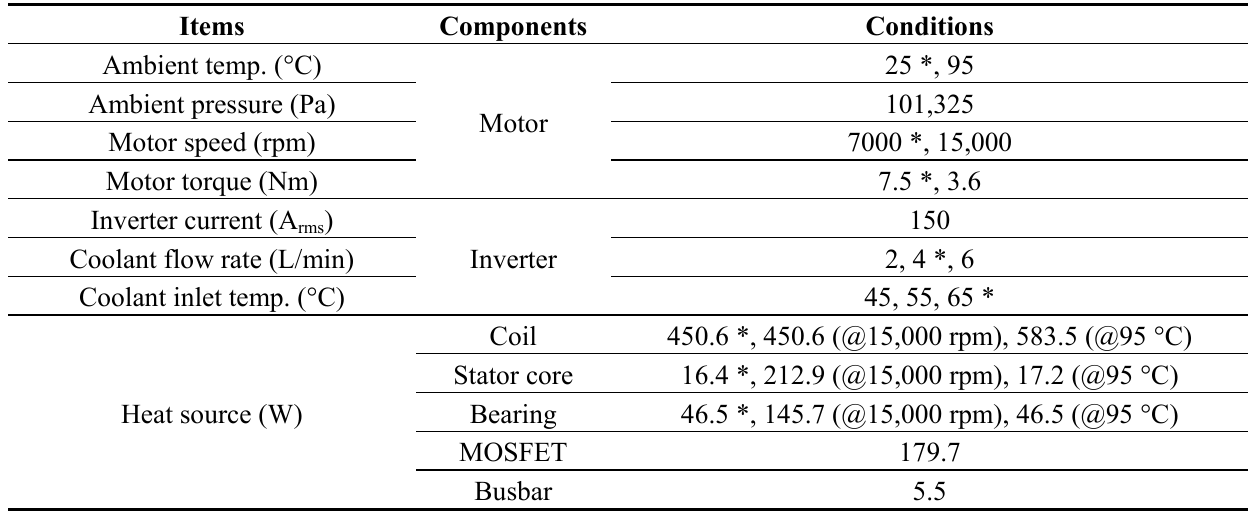
Table 1. Boundary conditions. MOSFET: metal-oxide-semiconductor field-effect transistor. Items